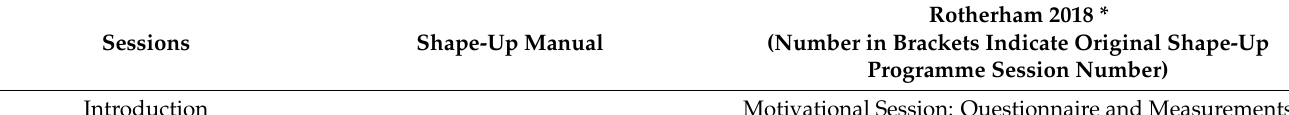
Table 4. Comparison of the Shape-Up manual and how the programme was delivered in Rotherham in the period studied (January–March